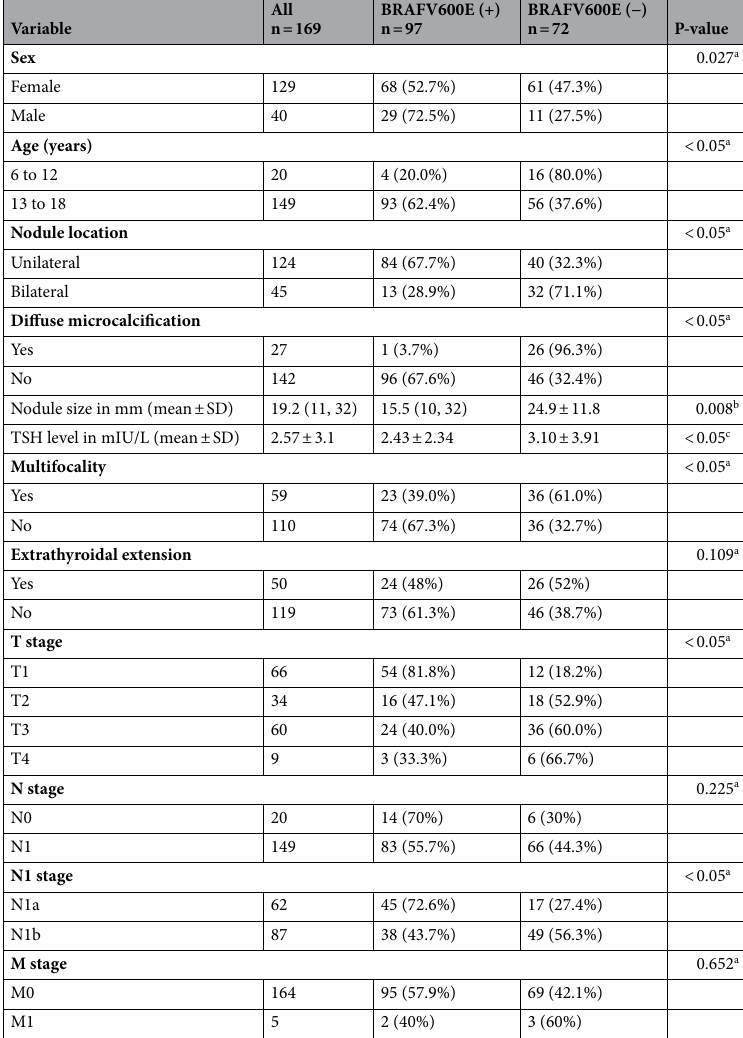
Table 1. Relationship between BRAFV600E gene mutations and clinicopathological characteristics of papillary thyroid carcinoma in pediatric patients. a Chi-square test. b Mann–Whitney test. c Independent- samples T